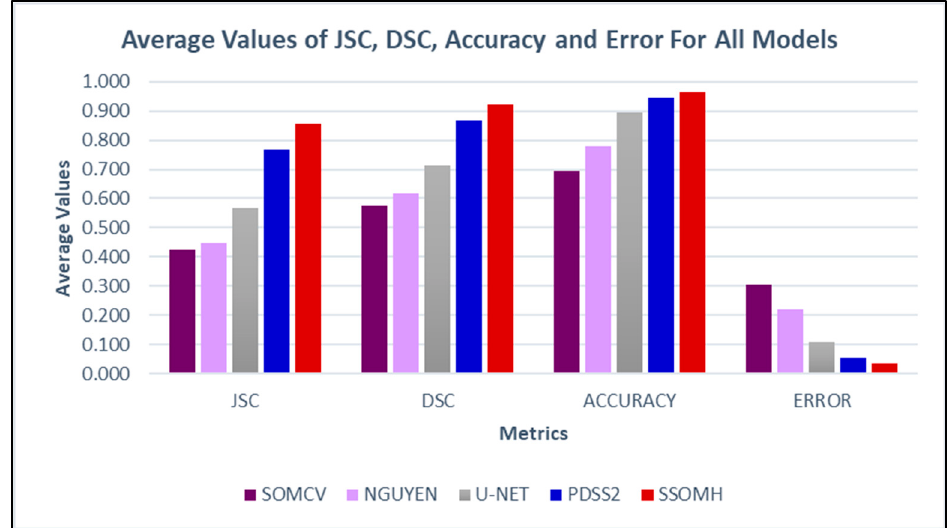
Figure 6. Average Values of JSC, DSC, Accuracy and Error for All Models. Table 4. Average Computation Time for All Models.